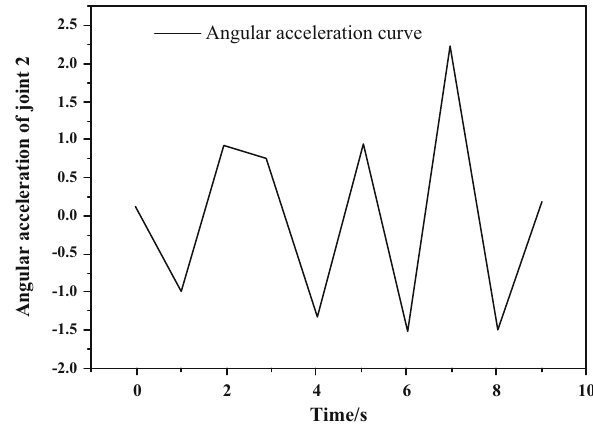
Figure 6: Angular acceleration curve of joint 2 of cubic B - spline programming.